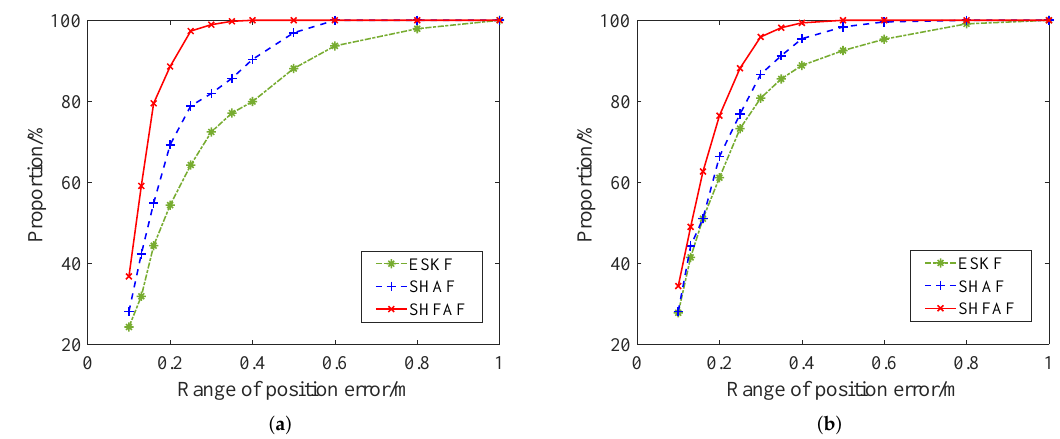
Figure 15. The distribution of positioning errors. ( a ) Trajectory A. ( b ) Trajectory B.